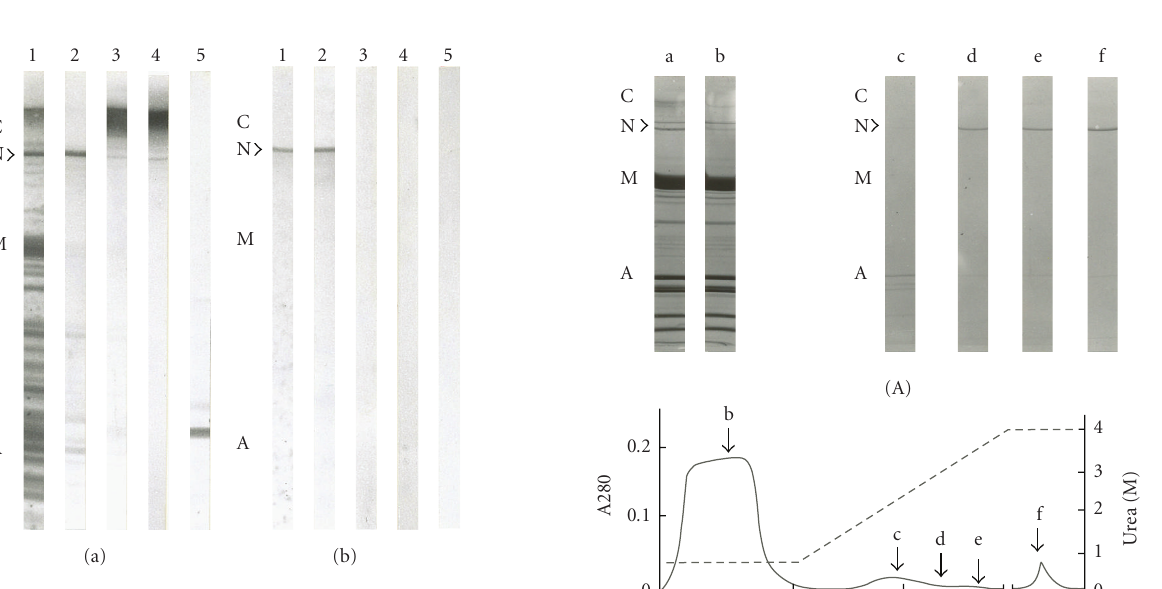
Figure 2: Immunoblot detection of purified nebulin. (a) SDS extract of whole rabbit back muscle, (b) nebulin fraction. (1) Amido black stained nitrocellulose sheets, (2) treated with PcNeb, (3) treated with Pc1200, (4) treated with Mc3B9, (5) treated with actin.